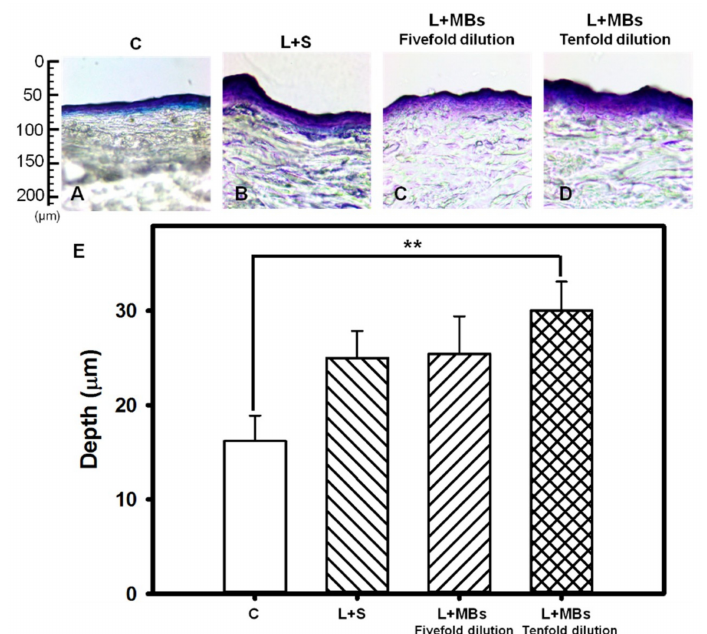
Figure 5. Light-microscope evaluation of pigskin samples with no treatment (group C) ( A ); for irradiation by the Nd:YAG pulsed laser combined with saline (group L + S) ( B ); and for laser irradiation combined with MBs (group L + MBs) diluted fivefold ( C ) and tenfold ( D ); ( E ) Quantification of the penetration depths of Evans blue in panels ( A – D ) (** p < 0.01). Data are mean and SD values.